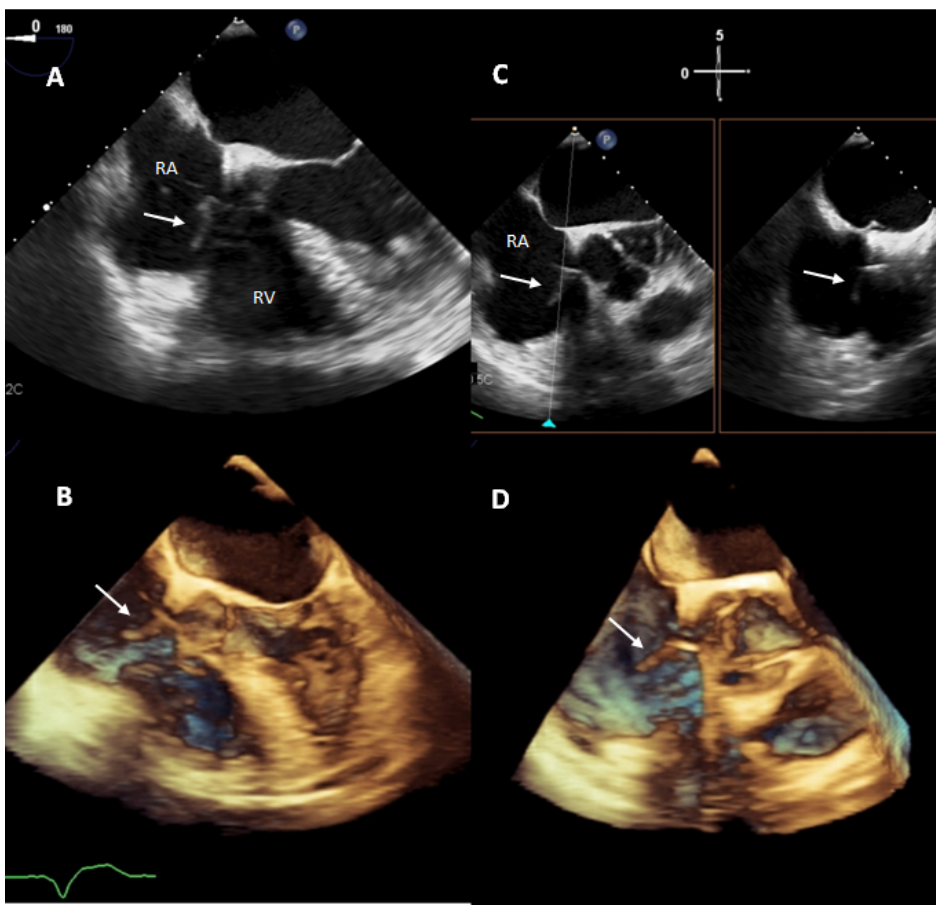
Figure 3. Transesophageal echocardiogram, 5 chamber view, showing a vegetation (19 × 6 mm) adherent to pacemaker’s ventricular lead in 2D (panel ( A ), white arrow) and 3D (panel ( B )). The same vegetation is also shown in right ventricular inflow-outflow view (and its orthogonal plane-bicaval view) in 2D (panel ( C )) and in 3D (panel ( D )). RV: right ventricle; RA: right atrium.